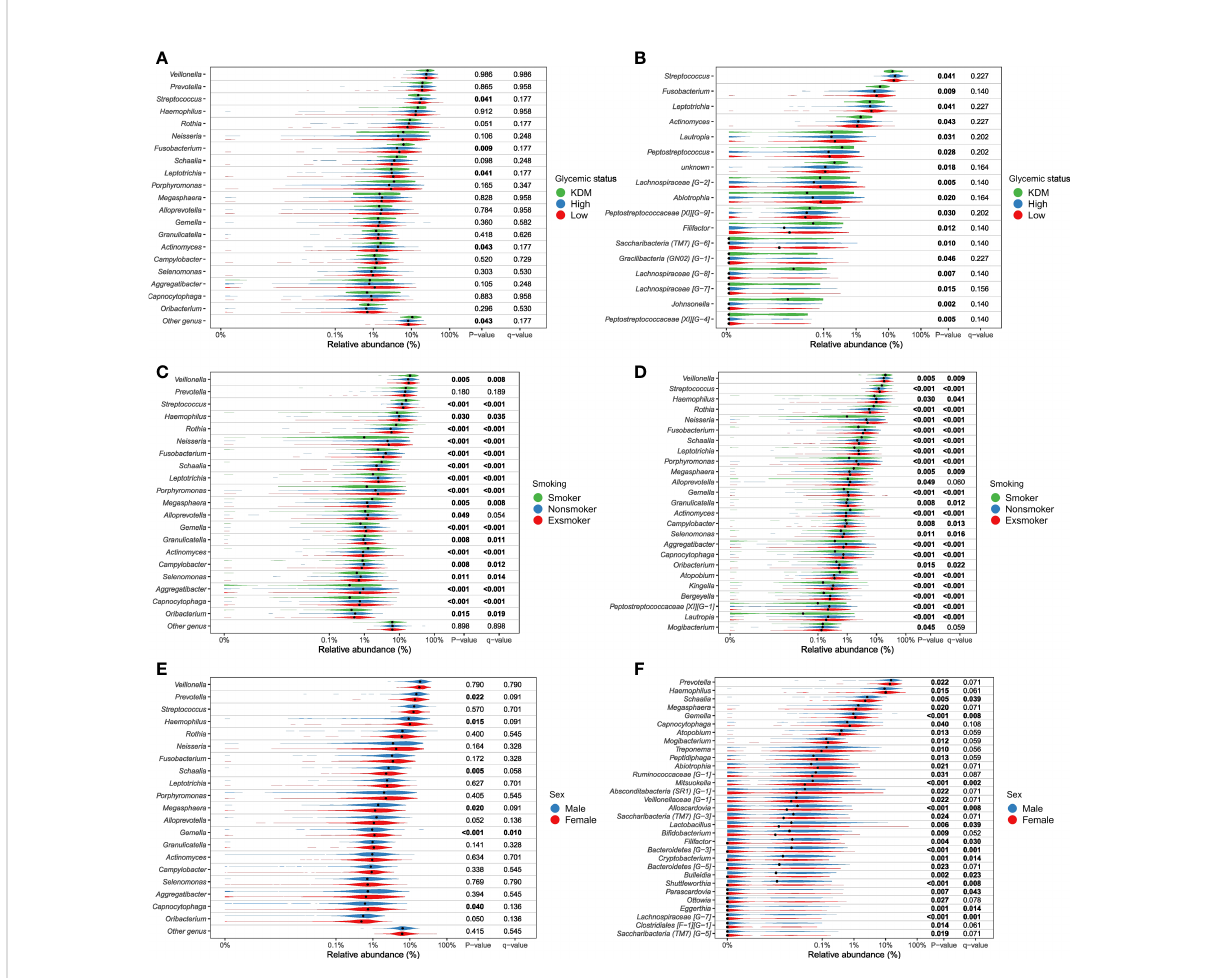
FIGURE 4.1 Genera signi fi cantly associated with glycemic status, smoking and sex. Relative abundance of most abundant genera (panels A , C , E ) and differential abundant genera (panels B , D , F ). Comparison of groups were performed with non-parametric tests (Kruskal-Wallis). Unadjusted p- values as well as Benjamini-Hochberg corrected q-values are included in the plot. (A, B) , glycemic status, (C, D) , smoking status, (E, F) , sex. All tests are included in Supplementary File 2 as well as a parametric approach (DESeq as implemented in DAtest) in Supplementary fi le